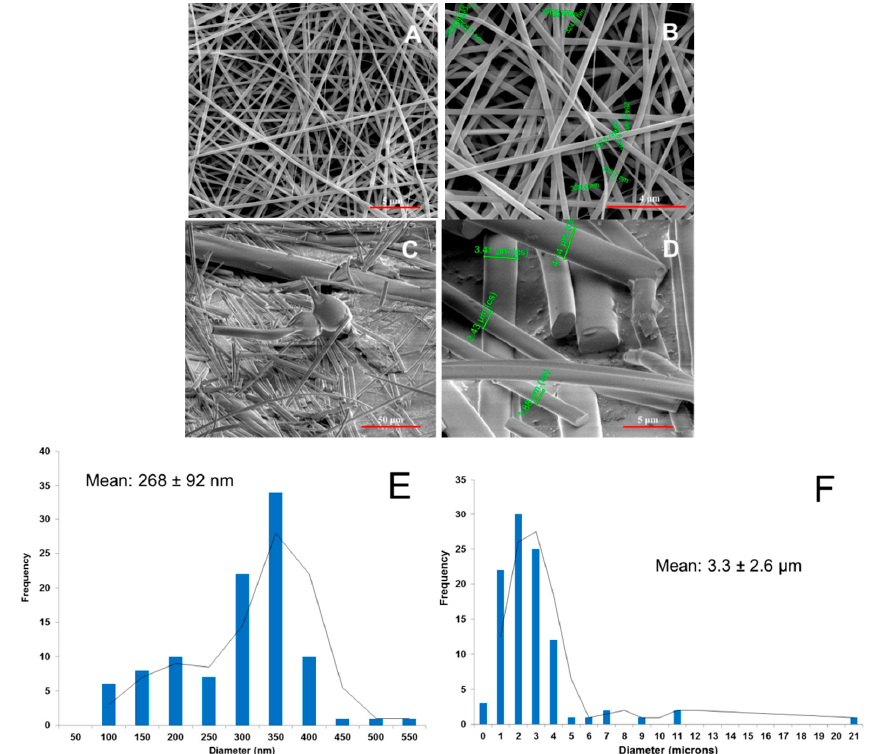
Figure 3. SEM images of piroxicam (PRX)-loaded hydroxypropyl methylcellulose (HPMC) ( A,B ) nanofibers and polydextrose (PD) ( C,D ) fibers. Magnification of SEM: 5000 × ( A ), 10000 × ( B ), 600 × ( C ), and 5000 × ( D ). ( E ) Fiber size distribution of the PRX-loaded HPMC nanofibers; ( F ) Fiber size distribution of the PRX-loaded PD